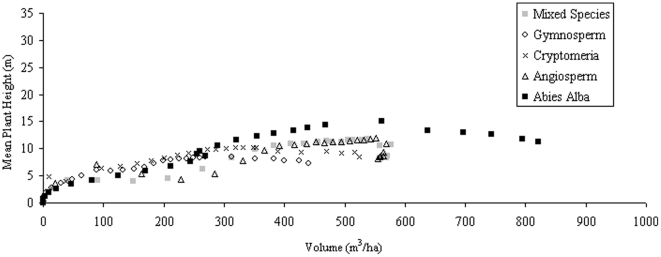
Hmean against forest volume for planting densities of 10000 ha−1.